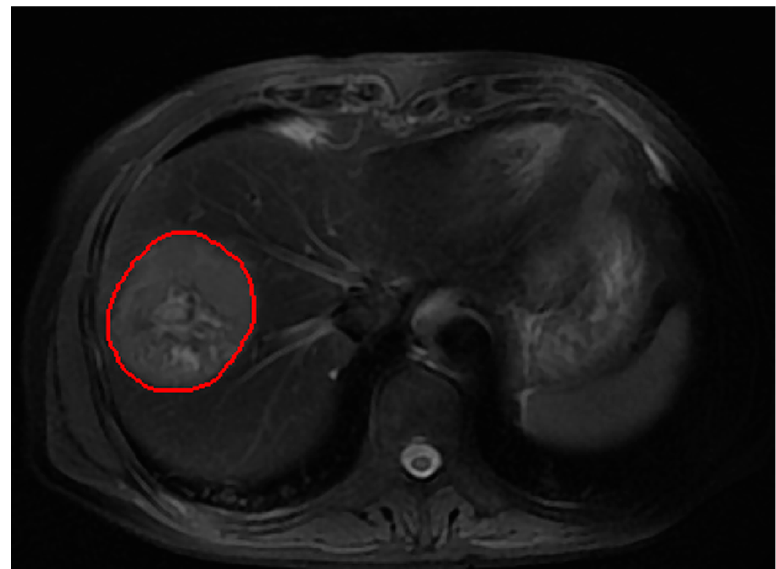
Figure 1. An example of the tumor VOI segmentation on T2WI.